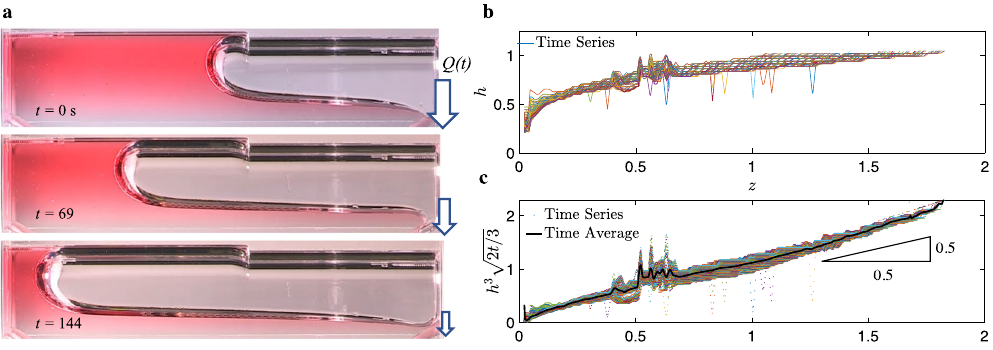
Fig. 3 ICF single drain fl ow. a Time sequence of perfectly wetting θ = 0 ∘ red-dyed 2 cs PDMS in the ICF-4 test chamber drained through the “ small-end ” exit port at right. Note that the top image shows the ideal interface position at the drain port, the middle image shows gas ingestion, and the lower image shows an under-drained condition. b , c Dimensionless corner fl ow interface height pro fi le h ( z , t ) for small-end drain tests for the ICF-4 test cell: b h ( z , t ) and c h 3 (2 t /3) 1/2 self-similar lubrication model solution with right triangle depicting slope of unity despite unequally scaled axes. The arbitrarily colored lines in b and dots in c are incremented at 1 Hz for the full 128 s run. In b the h ( z , t ) pro fi les decrease and extend with time, whereas in c they scatter about the time-averaged value (black